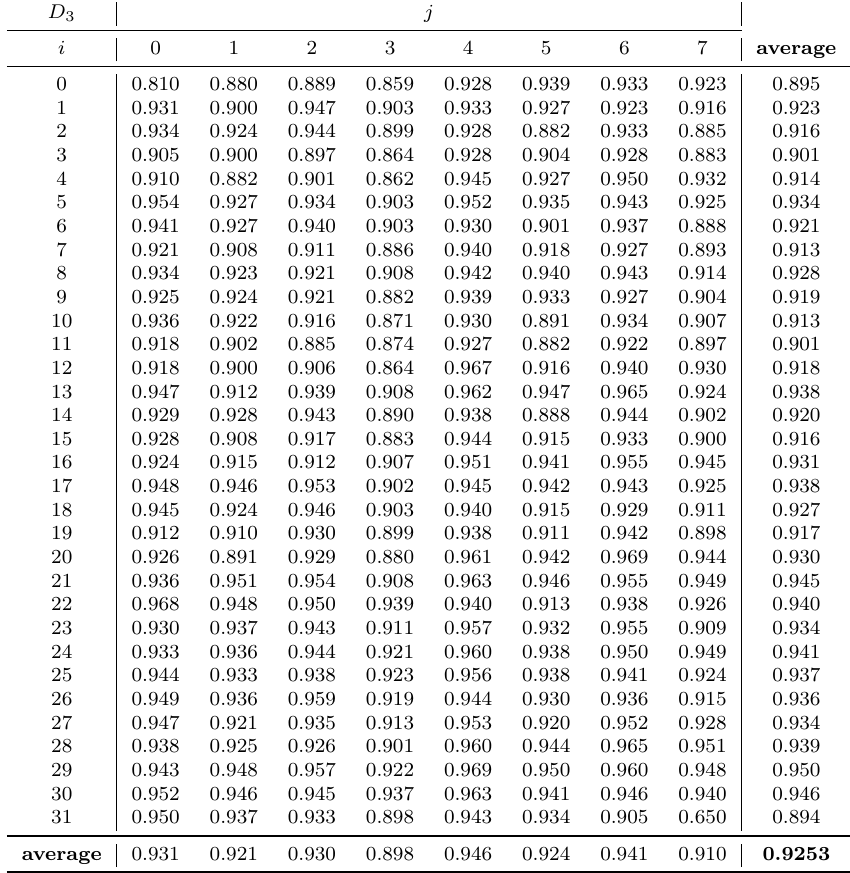
Table 17: Empirical probability to recover the message bit m [8 i + j ] from a single trace using poly_A2A() . Average results for 1K traces from device D 3 . D